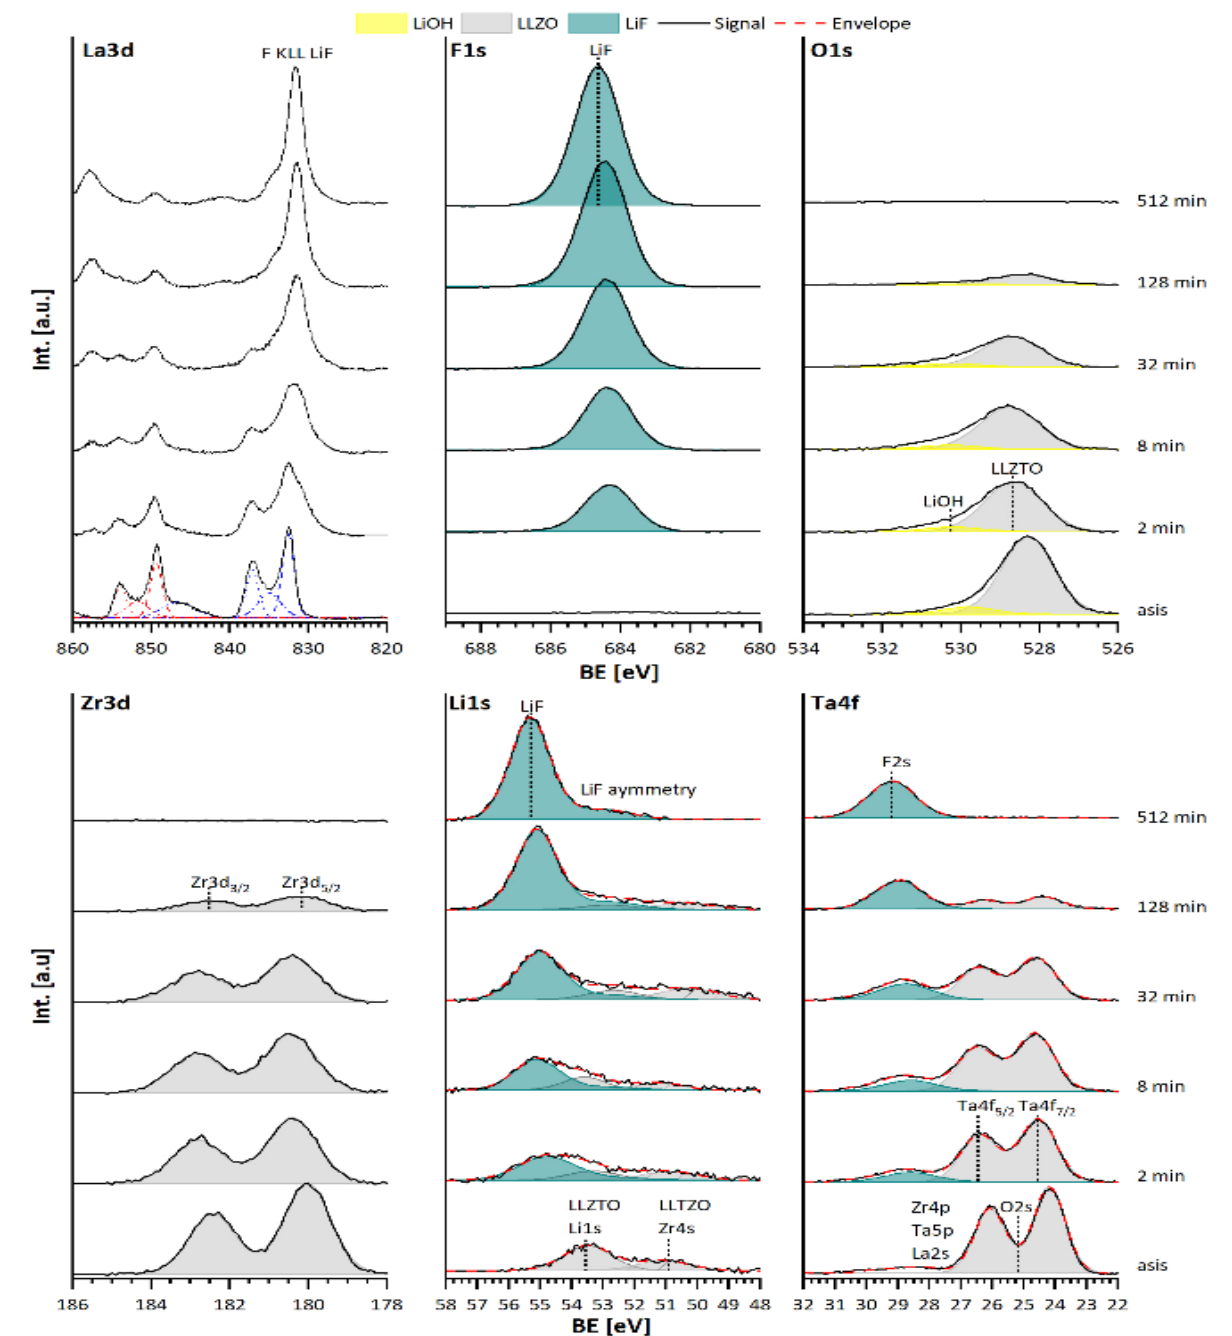
Figure 4. La3d, F1s, O1s, Zr3d, and Ta4f XP spectra of the interface between LLZTO and LiF, where “asis“ denotes the annealed LLZTO substrate deposition times of LiF from 2 min up to 512 min. At this point it is clear that the LiTFSI is significantly decomposed and has reacted at the surface of the LiF, since no LiTFSI emission lines could be detected. The authors think that this likely results from a surface stabilization of the LiF surface. In contrast, the typical emission lines for the PEO can be detected, which leads to the assumption that it remains mostly intact. However, we acknowledge that it is not straightforward to deduce smaller degrees of reaction for the PEO, since the carbon-containing products may originate from LiTFSI only or LiTFSI and PEO